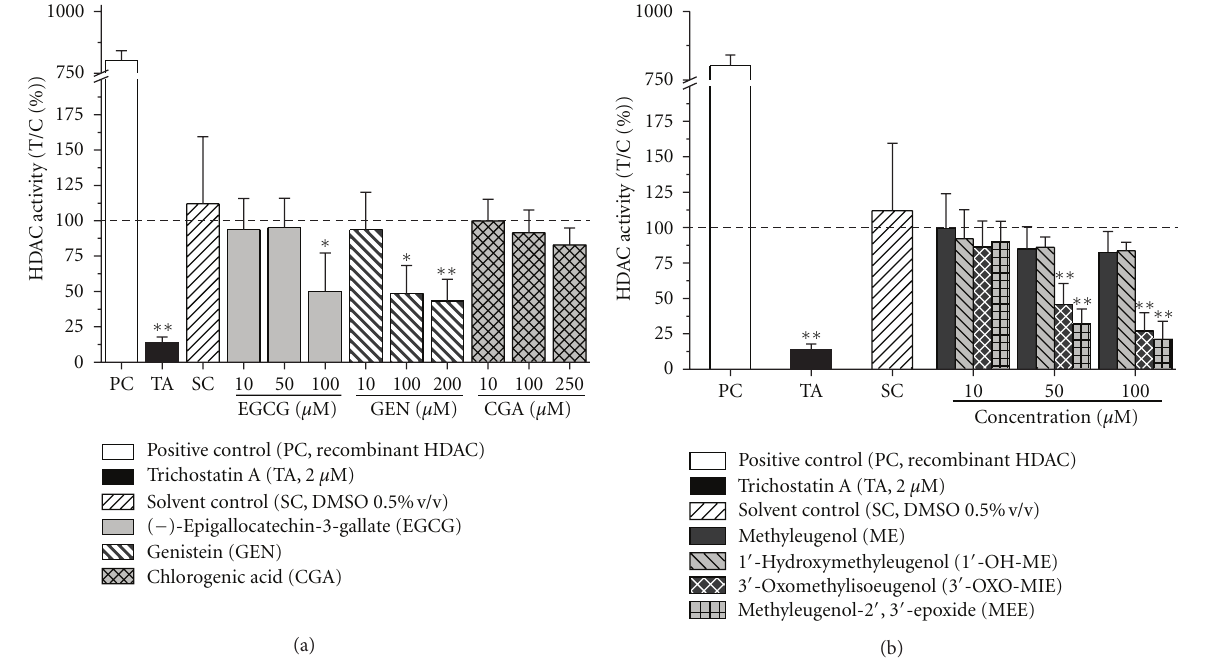
Figure 3: Inhibition of HDAC1 activity in HT29 cells after 24h of incubation with (a) polyphenols in the presence of catalase (100U/mL) or (b) methyleugenol and methyleugenol metabolites. HDAC activity was determined by the metabolic rate of a specific HDAC1 substrate. Recombinant HDAC1 was included as positive control (PC) and trichostatin A (TA) as a specific HDAC inhibitor. The data presented are mean ± SD of at least three independent experiments, each performed in a duplicate. The significances indicated were calculated in relation to the solvent control DMSO 0.5% v/v (Student’s 𝑡 -test: ∗ 𝑃 ≤ 0.05 ; ∗∗ 𝑃 ≤ 0.01